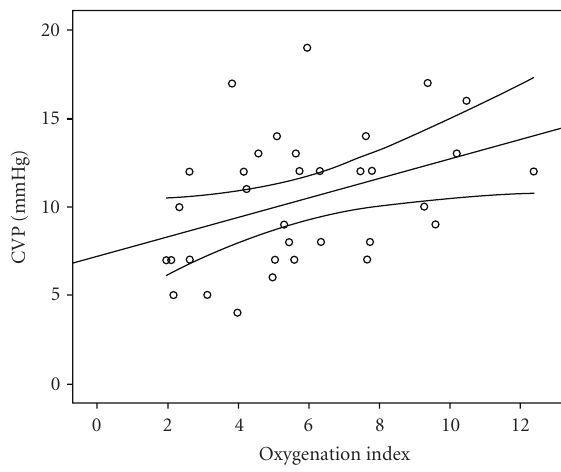
Figure 1: Correlation (with 95% confidence intervals) between baseline CVP and Oxygenation Index ( R = 0 . 39; P = . 021).